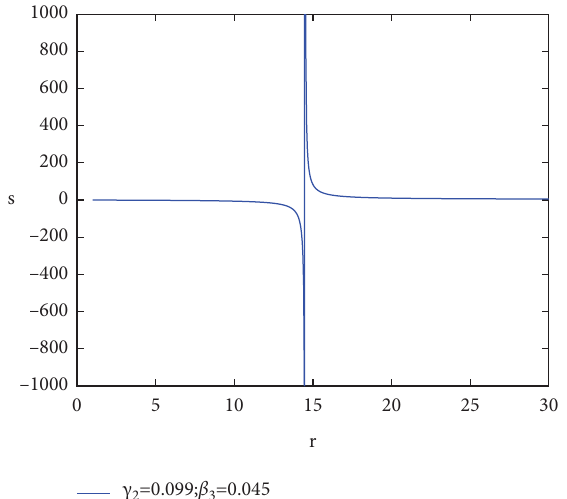
Figure 14: Statefnder plane ( r − s ) for BT-VIII.